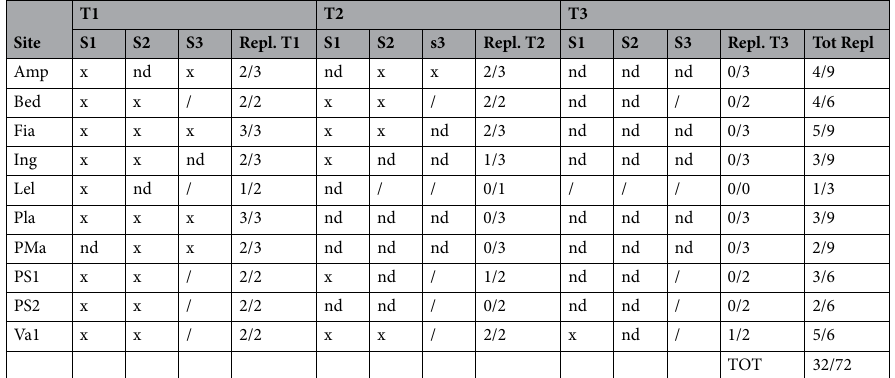
Table 1. Spatial and temporal replicates included in the eDNA metabarcoding study of Rana temporaria in the Province of Trento, Italy. T1, T2, T3 = temporal replicates 1, 2, and 3; Repl. T1, Repl. T2, Repl. T3: for every temporal point, the sum of spatial replicates per site is reported (positive/total); S1, S2, S3 = spatial replicates 1, 2, and 3; x = sampling was performed and positive results were obtained after sequencing; nd = sampling was performed but amplification was not successful (no DNA bands visible on the Qiaxcel Advanced System (Qiagen) and/or several samples were sequenced for confirmation and no R. temporaria DNA was detected); / = sampling was not performed because the structure of the wetland site was not compatible with three spatial replicates (see text for details) or, (for T3) one of the previously selected water microhabitats was no longer physically accessible or non-existent (due to seasonal changes in wetland extent and